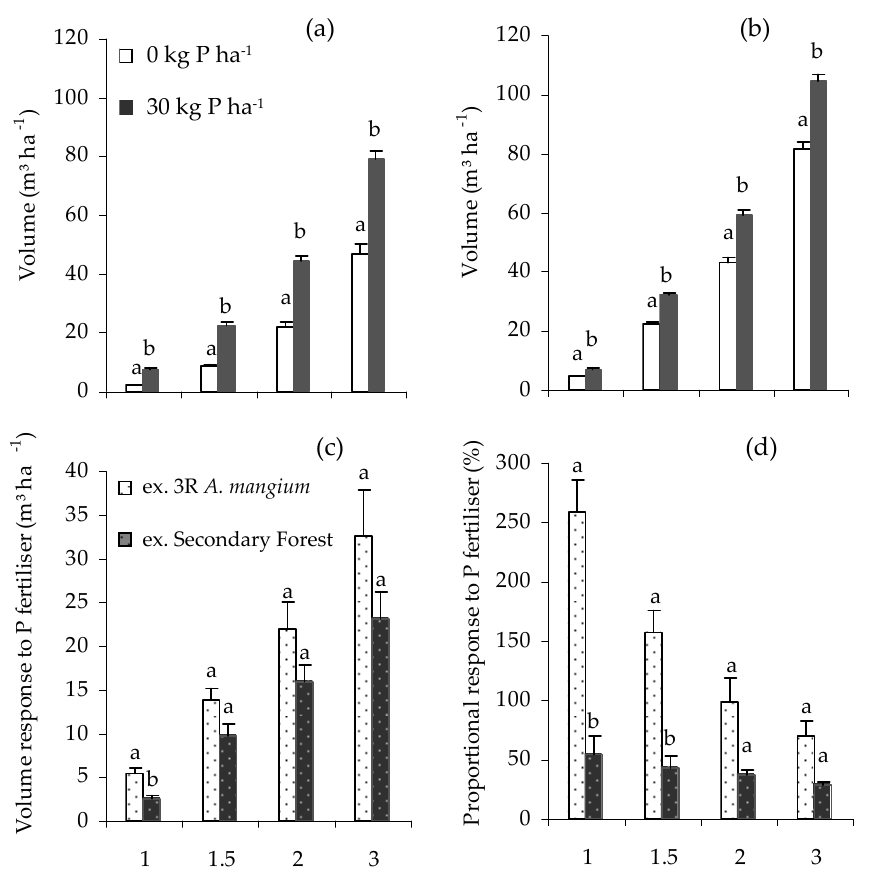
Figure 1. Response to P across plantation ages: standing volume, V , between P0 and P30 at ( a ) Core Gemawang; ( b ) Satellite III secondary forest; ( c ) V response to P; ( d ) proportional V response to P. Error bars represent one standard error. Volume response is the difference between the volume of unfertilised and fertilised treatment, while proportional response is volume response divided by the volume of unfertilised treatment (expressed as a percentage). Within the same planting age, bars having the same letter did not differ significantly according to ANOVA ( p < 0.05).